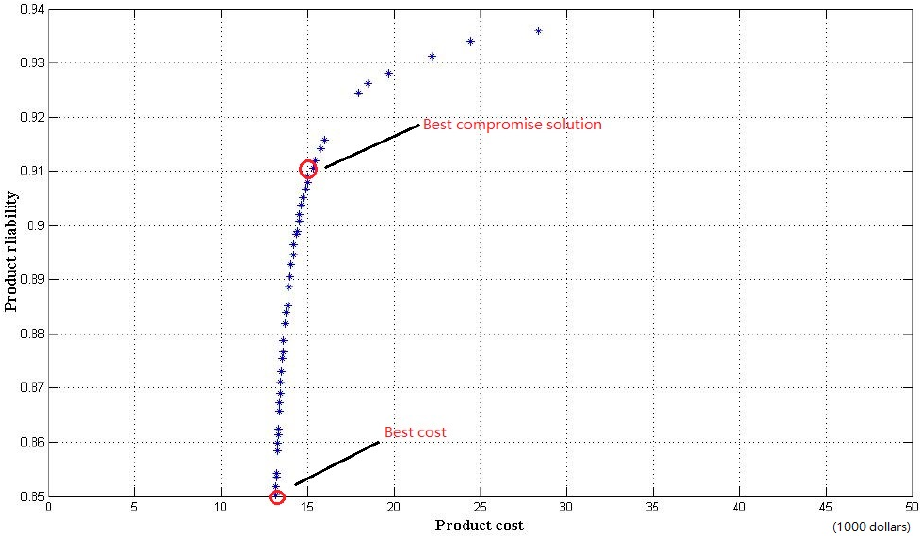
Figure 8. Best compromise solution in partial magnification of the Pareto fronts acquired by Culture-based DMOPSO.